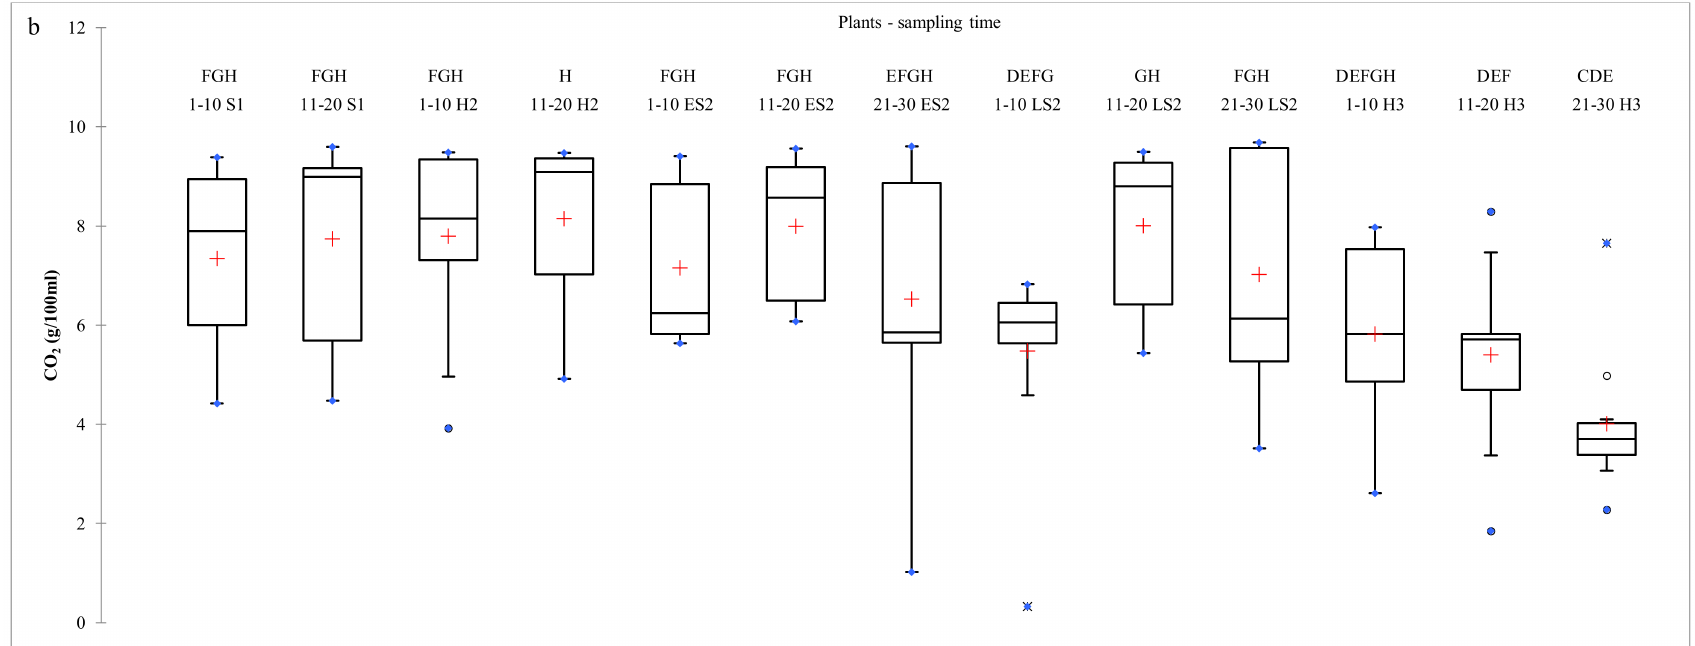
Figure 2. CO 2 production at about 800 h of fermentation of bark samples collected from the YV ( a ) and the OV ( b ). Di ff erent letters above the boxplots indicate significant di ff erences between the average CO 2 values calculated for the 10 plants of each row in the two vineyards, according to the Tukey’s test ( p ≤